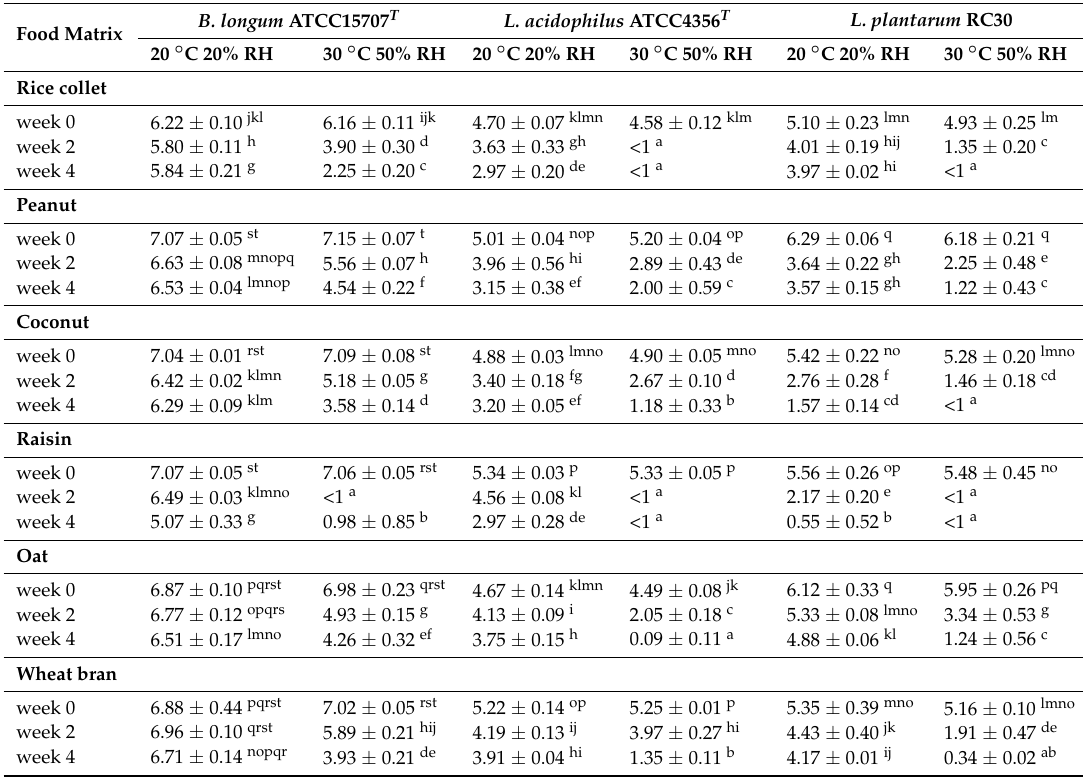
Table 1. Probiotic bacteria log cfu g − 1 recovered from samples coated with B. longum ATCC15707 T , L. acidophilus ATCC4356 T , and L. plantarum RC30 as affected by food matrix, storage temperature, and humidity during four